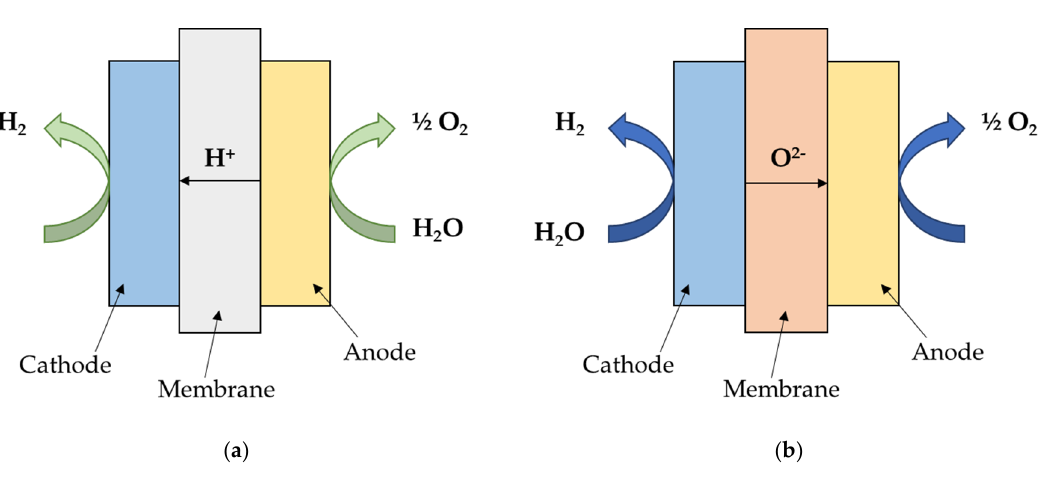
Figure 2. ( a ) Schematic representation of polymer electrolyte membrane (PEM) electrolysis; ( b ) Schematic representation of solid oxide electrolyzer cell (SOEC) electrolysis.